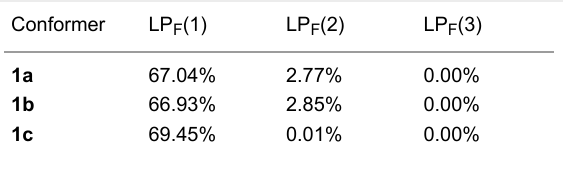
Table 4: Percentage s-character of fluorine lone pairs in the conformers of 2-fluorophenylboronic acids.